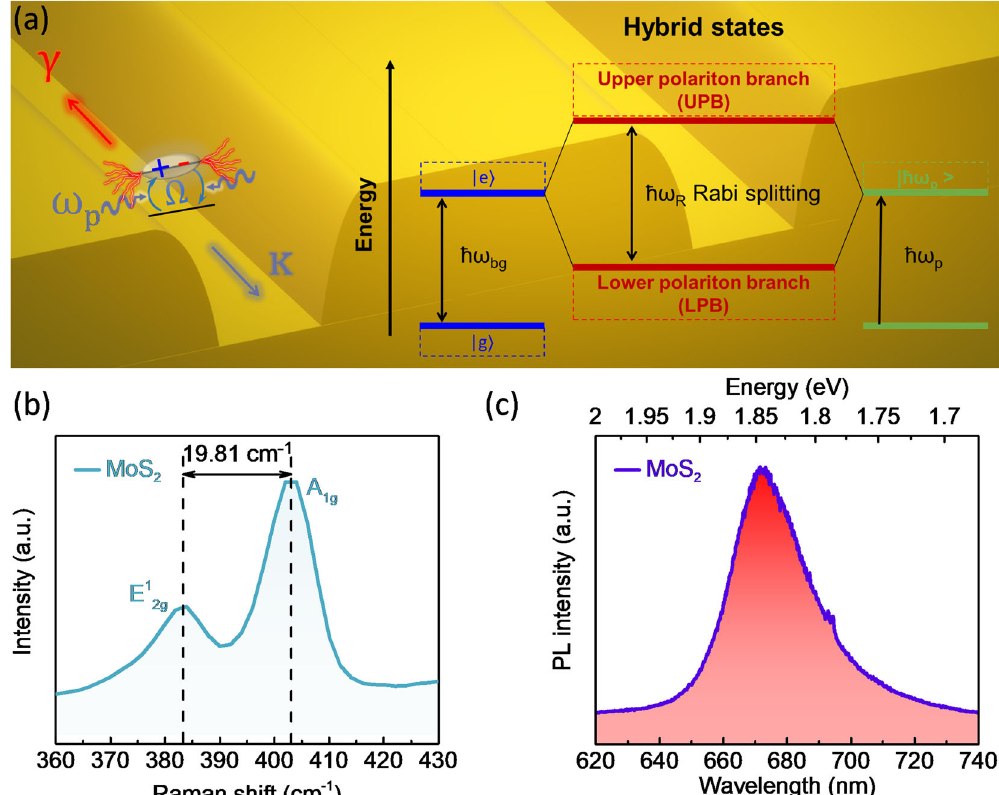
Fig. 1 Rabi splitting and optical characterization of MoS 2 . a Exciton – polariton coupling system between a plasmonic cavity with a resonant Ω , cavity loss rate γ , ω p and TMD excitons. In this system, the parameters that determine the coupling strength are the energy-exchange rate and emitter loss rate κ . The right panel depicts the energy diagram of the strong coupling of the 2D TMD semiconductor with a direct bandgap ћ ω bg between the ground state |g 〉 and excited state |e 〉 coupled to the plasmonic-cavity mode ћ ω p . The coherent coupling forms a hybrid state with UPB and LPB separated by Rabi splitting energy ћ ω R . b The Raman spectra of the MoS 2 monolayers after being transferred on the Au fi lm. The frequency difference between the E 1 and A 1g modes is 19.81 cm – 1 , which indicates monolayers. c PL spectra of the MoS 2 2g